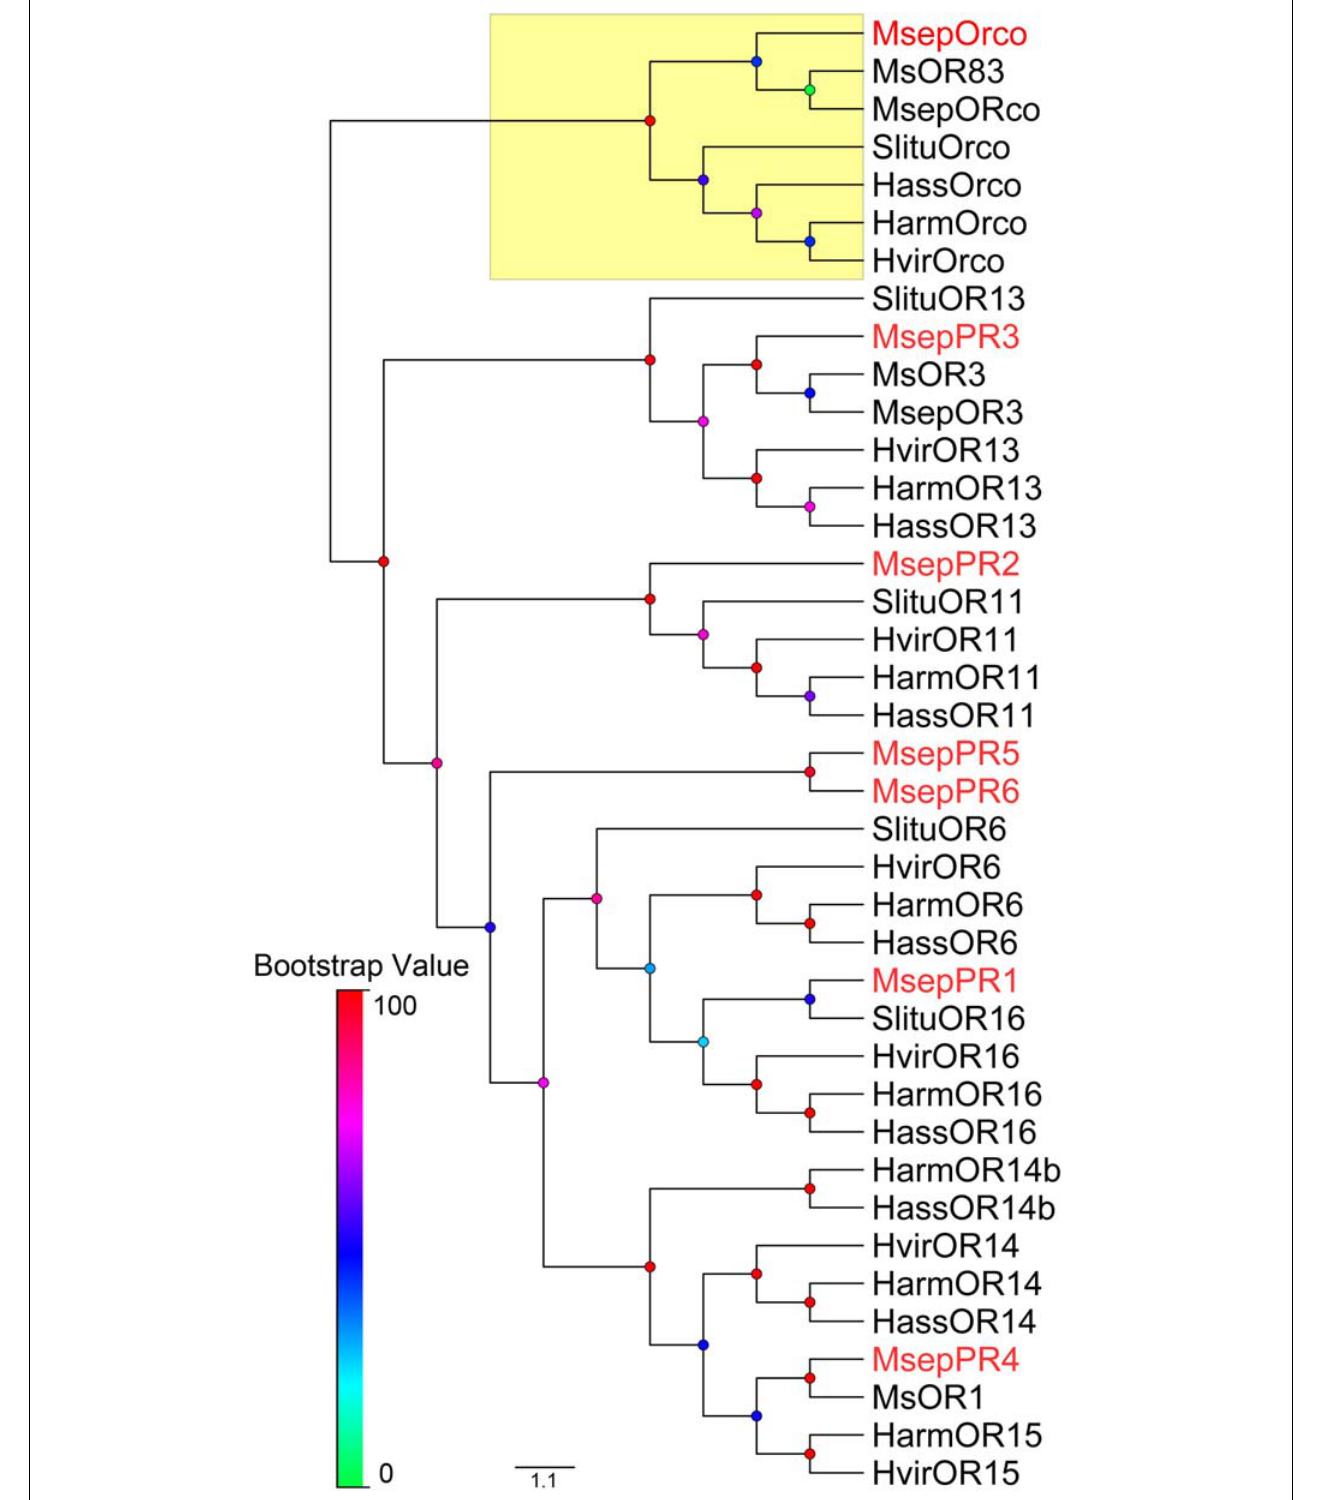
FIGURE 4 | Phylogenetic tree of PRs from M. separata and four other Lepidoptera species. Msep: M. separata (red), Msep: M. separata (black, Jiang et al., 2019, 2020), Ms: M. separata (black, Mitsuno et al., 2008), Harm: Helicoverpa armigera , Hass: H. assulta , Hvir: Heliothis virescens , and Slitu: Spodoptera litura. The Orco clade is marked with yellow. This tree was inferred using the neighbor-joining method. Node support was assessed with 1,000 bootstrap replicates.